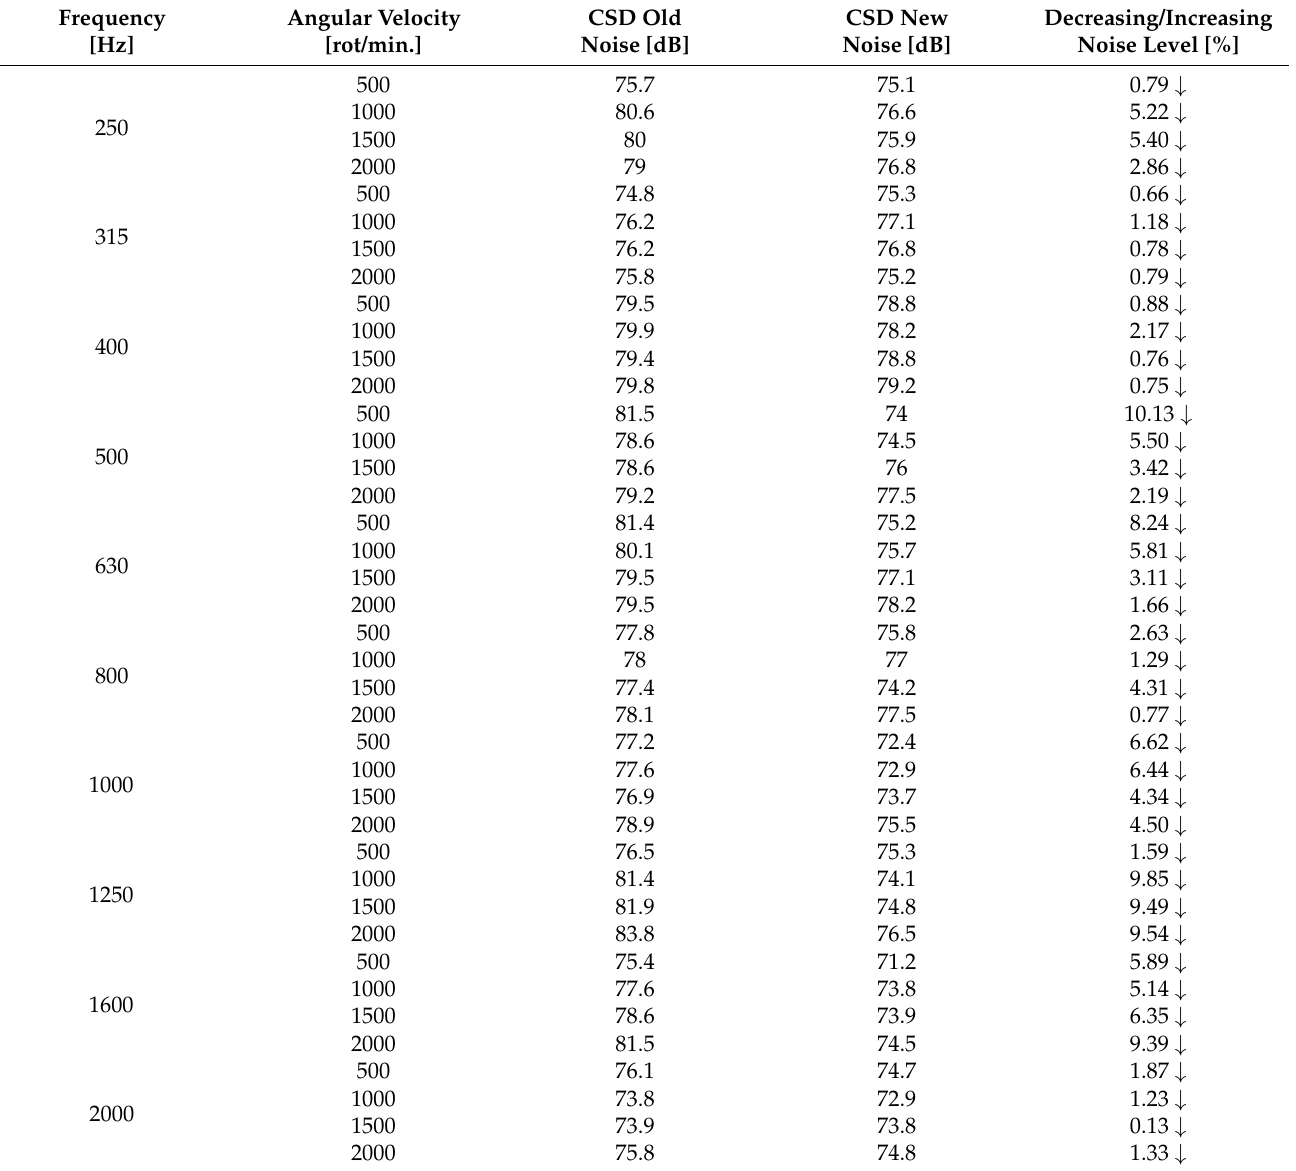
Table A7. Noise level on the lateral right surface of